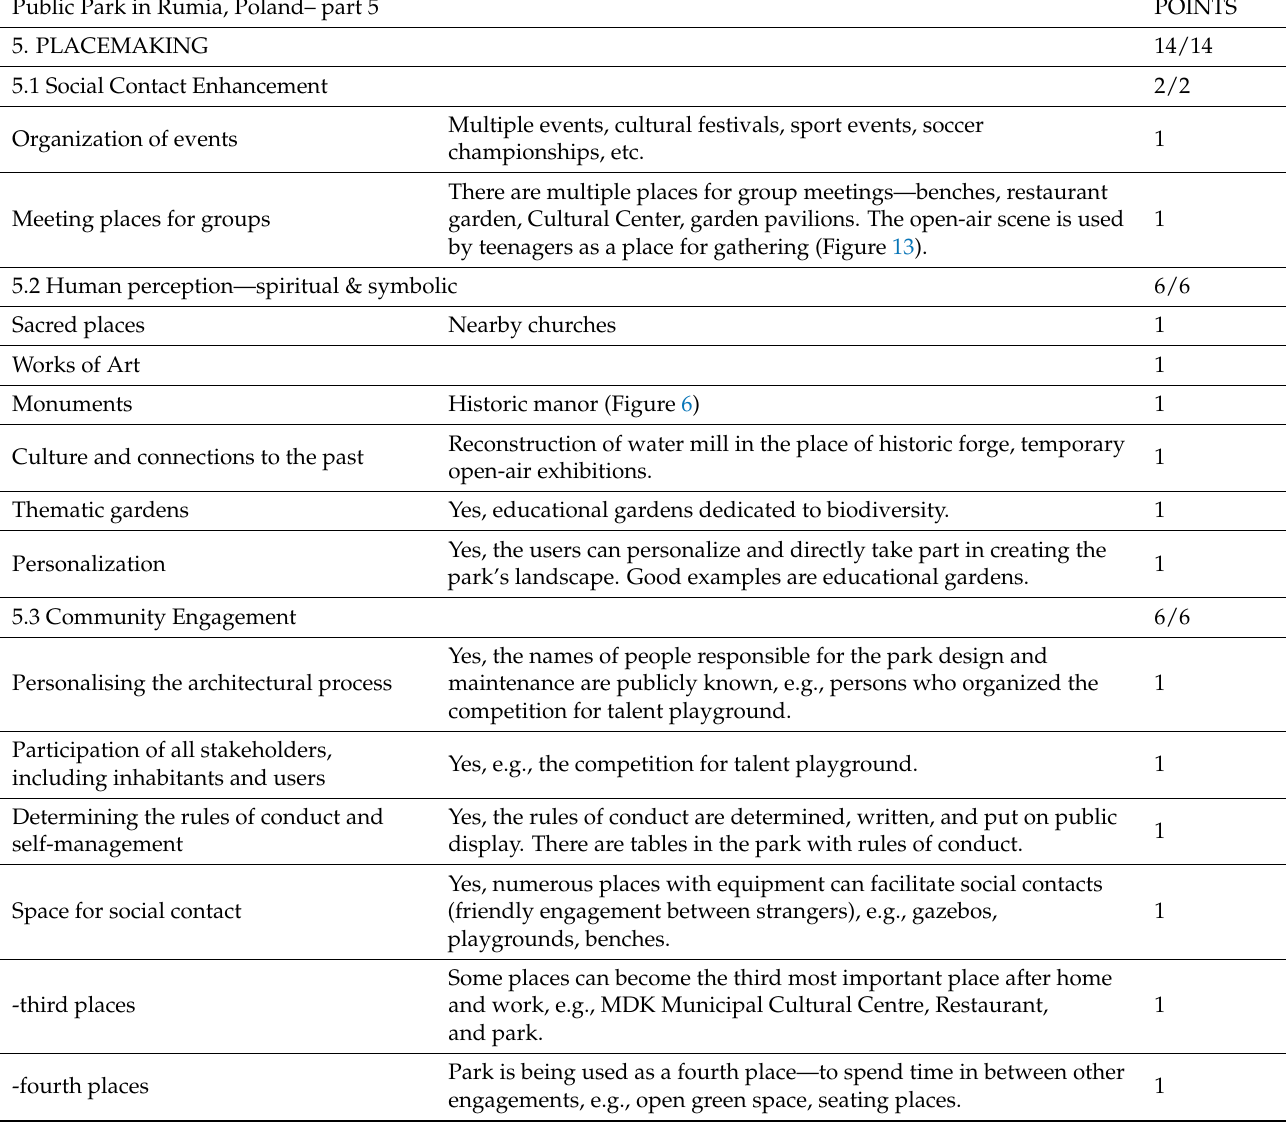
Table 5. Assessment of Public Park in Rumia, Poland—part 5, source: